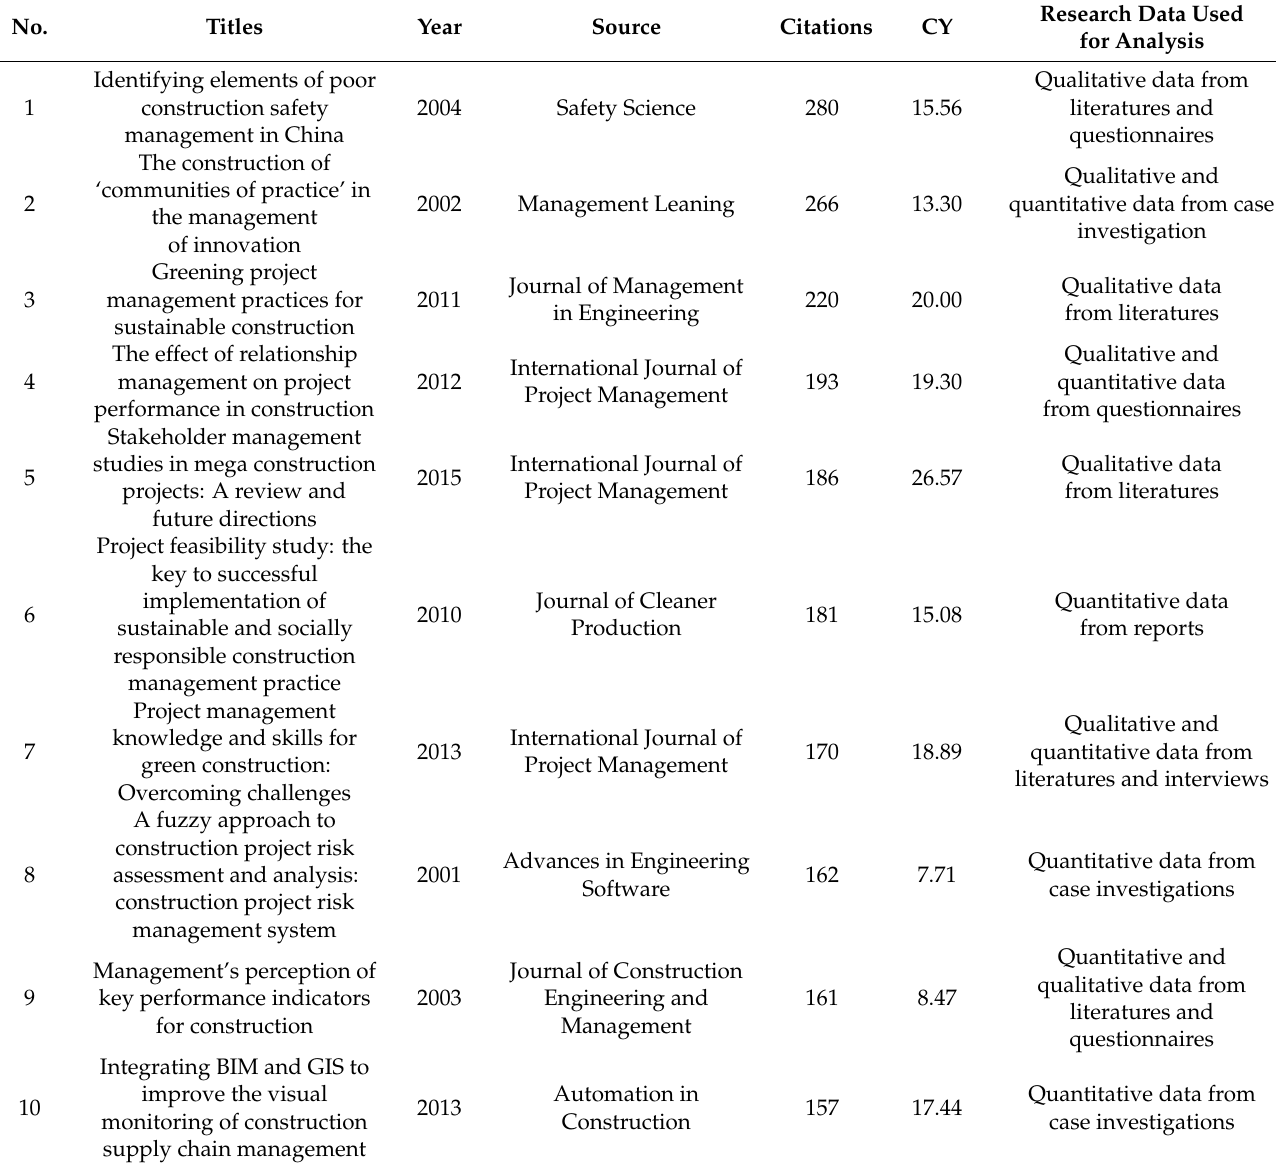
Table 3. Top 10 most cited articles in all